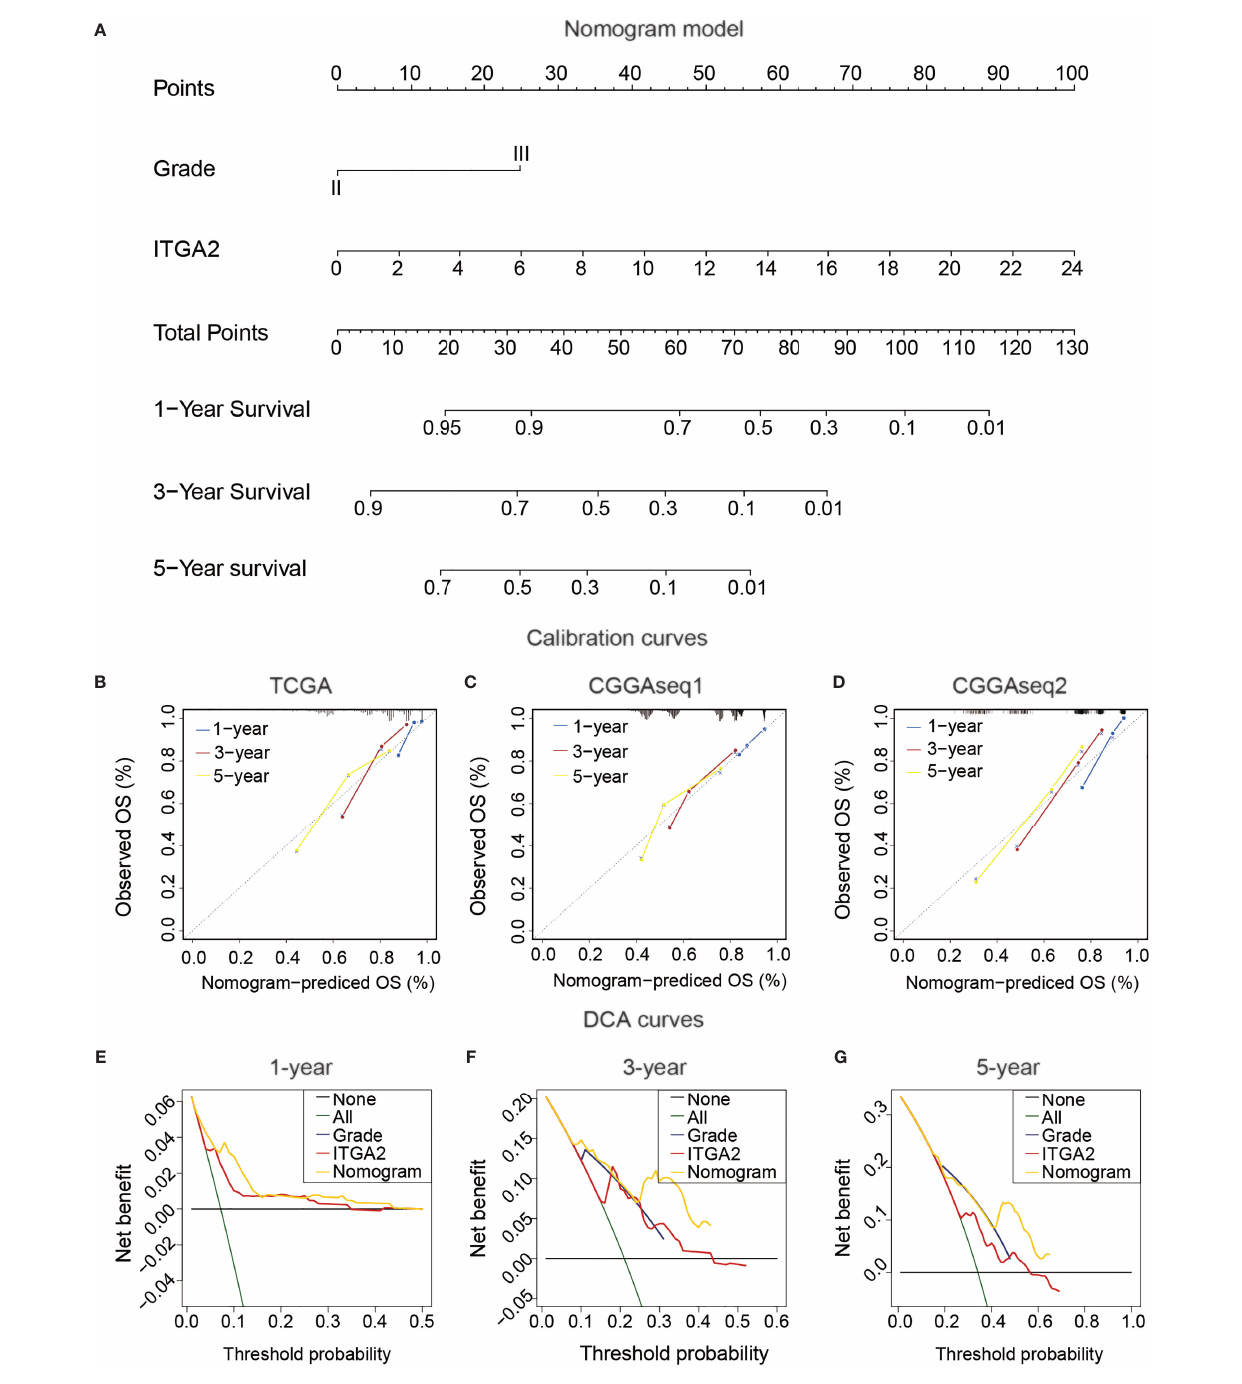
FIGURE 5 | Construction and con fi rmation clinical nomogram in patients with lower-grade glioma. (A) The Cancer Genome Atlas (TCGA) nomogram model of clinical features, including IDH status, 1p19q status, grade, and integrin alpha-2 expression. (B) TCGA calibration plots of the nomogram. (C, D) The validation of the TCGA nomogram in Chinese Glioma Genome Atlas CGGAseq1 and CGGAseq2. (E – G) The validation of Decision Curves Analysis (DCA) in TCGA cohort. (for estimating 1, 3, and 5-year OS).